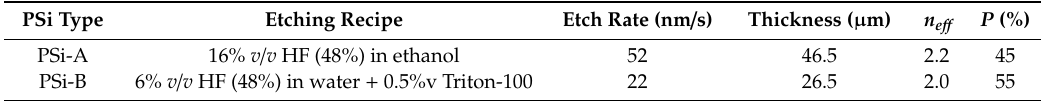
Table 2. Summary of PSi parameters. n e ff is the PSi e ff ective index and P is the